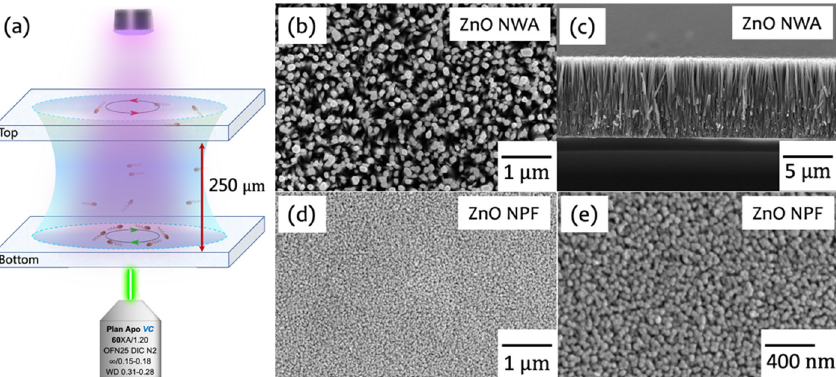
Figure 1. Experimental setup and SEM images of ZnO nanostructures. ( a ) Schematic bacterial swimming within the sandwich confinement. The bacterial suspension is surrounded by four plastic side walls to avoid evaporation. ( b , c ) are SEM images of ZnO NWA from the top and side view, respectively. ( d , e ) are SEM and zoom-in images of ZnO NPF from the top view at different magnifications, respectively.